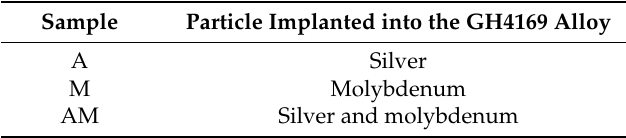
Figure 1. Schematic diagram of the multi-functional ion beam deposition system. Table 2. The particles implanted into GH4169 alloy substrates and the numbering.